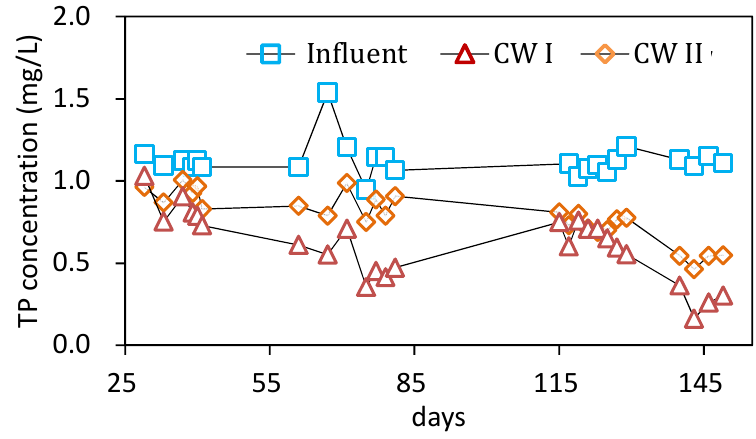
Figure 5. Influent and effluent concentration of TP in the second stage.